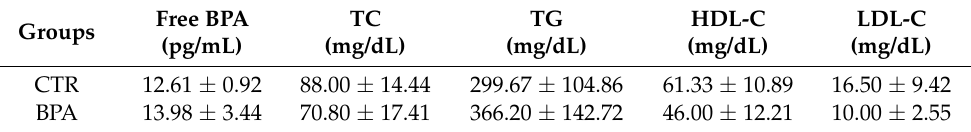
Table 1. Serum free BPA level and lipid levels of dams. Dams received 0.05% ethanol (control group,CTR) and 2.5 µg/kg/day of bisphenol A (BPA) for one month before and during pregnancy. Values are expressed as mean ± SD, n = 6 for each experimental group. Differences between groups were considered as significant at p < 0.05 and were analyzed by unpaired Student’s t test. Groups